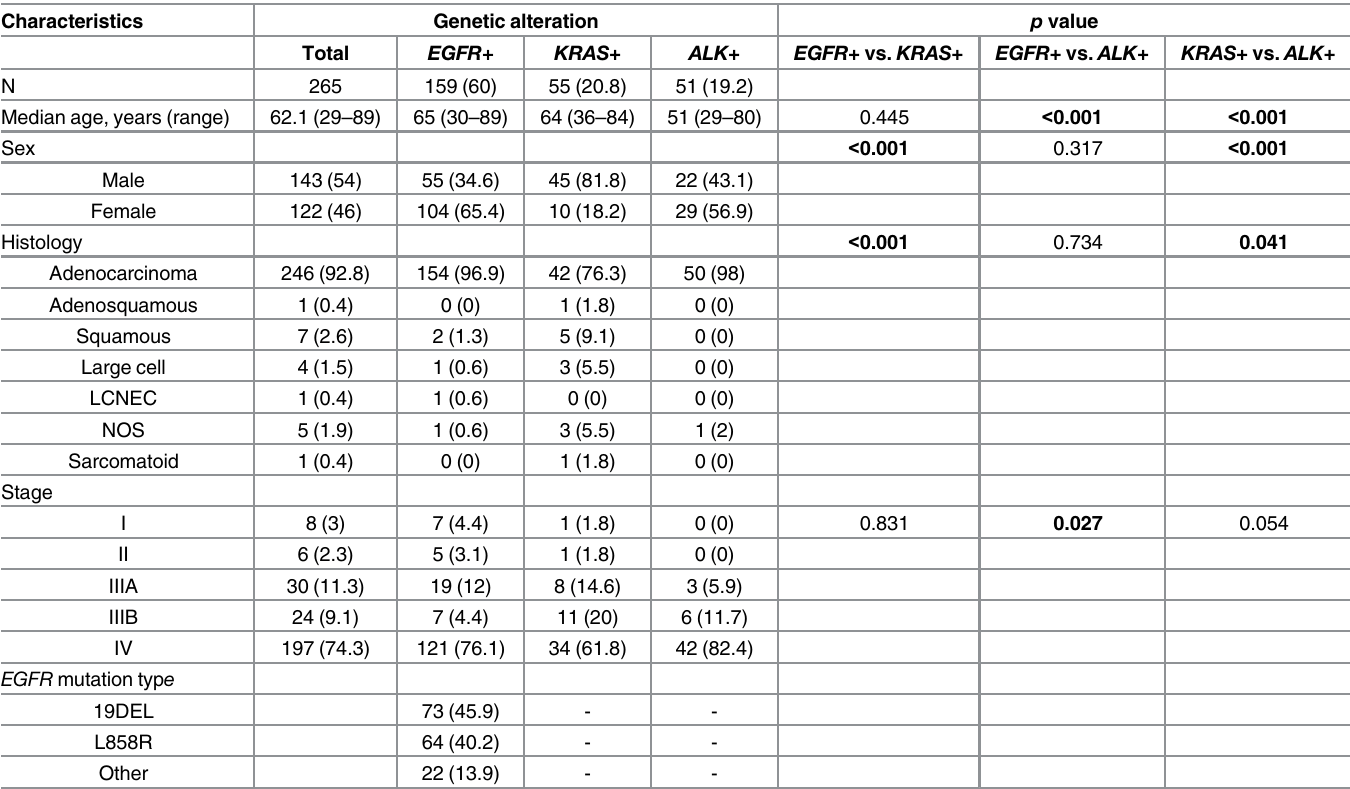
Table 1. Patients ’